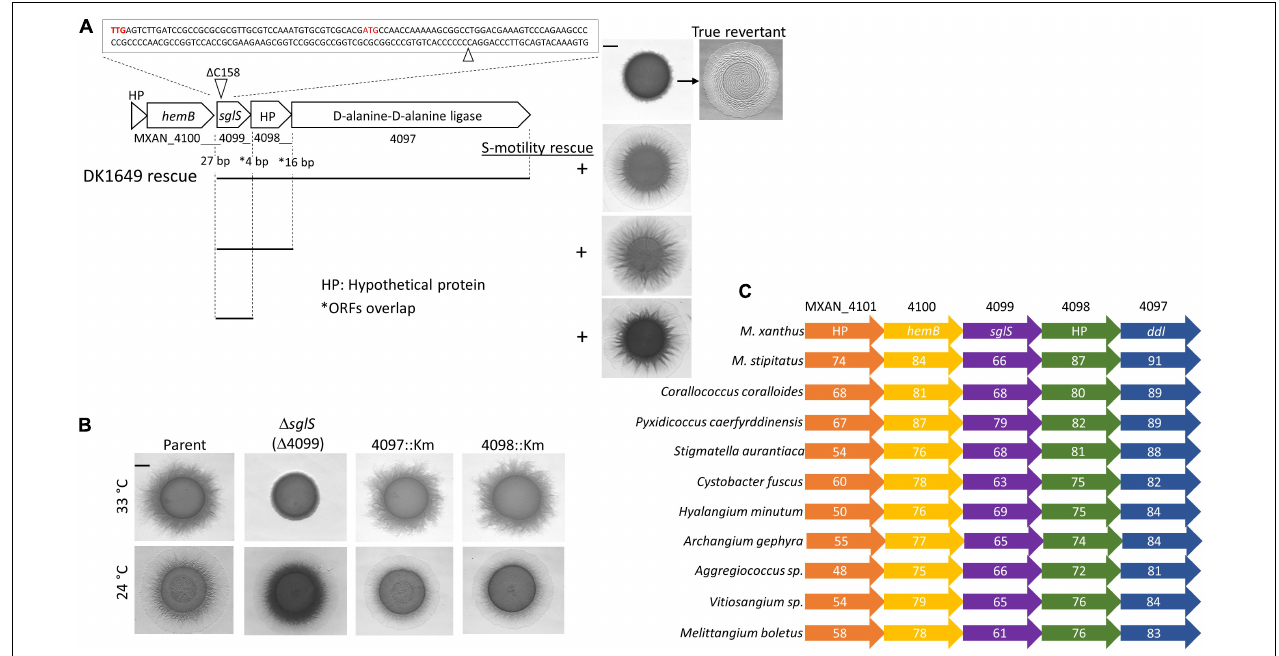
FIGURE 1 | Genetic analysis of the sglS locus. (A) Sequence of sglS -1649 (MXAN_4099) region. The location of the 1 bp deletion is marked by triangles. Two alternative start codons highlighted in red. Cluster ORFs labeled with locus tags or gene names. Gaps or overlaps ( ∗ ) between predicted reading frames indicated. Bottom, integrated DNA fragments (bars) used to rescue S-motility in DK1649 at 33 ◦ C (right). Top right, S-motility restored in a true revertant. (B) Isogenic strain set in an A − S + parent strain (DK1217). Strains incubated at indicated temperatures for 72 h on soft CTT agar. (C) Conserved myxobacterial five-gene cluster encompassing sglS . The percent identity to DK1622 ORFs are listed inside each ORF. Scale bars, 2 mm. Strains described in Supplementary Table 1